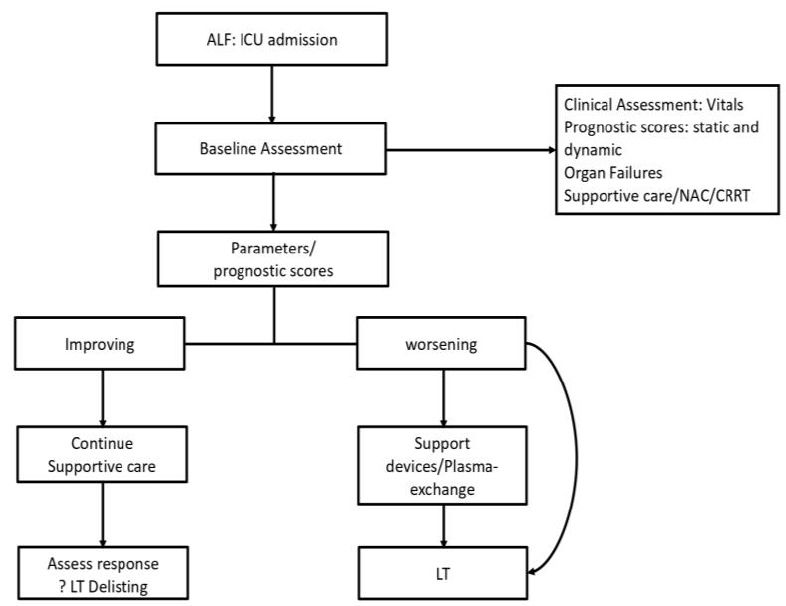
Figure 1. Suggested management algorithm for ALF.